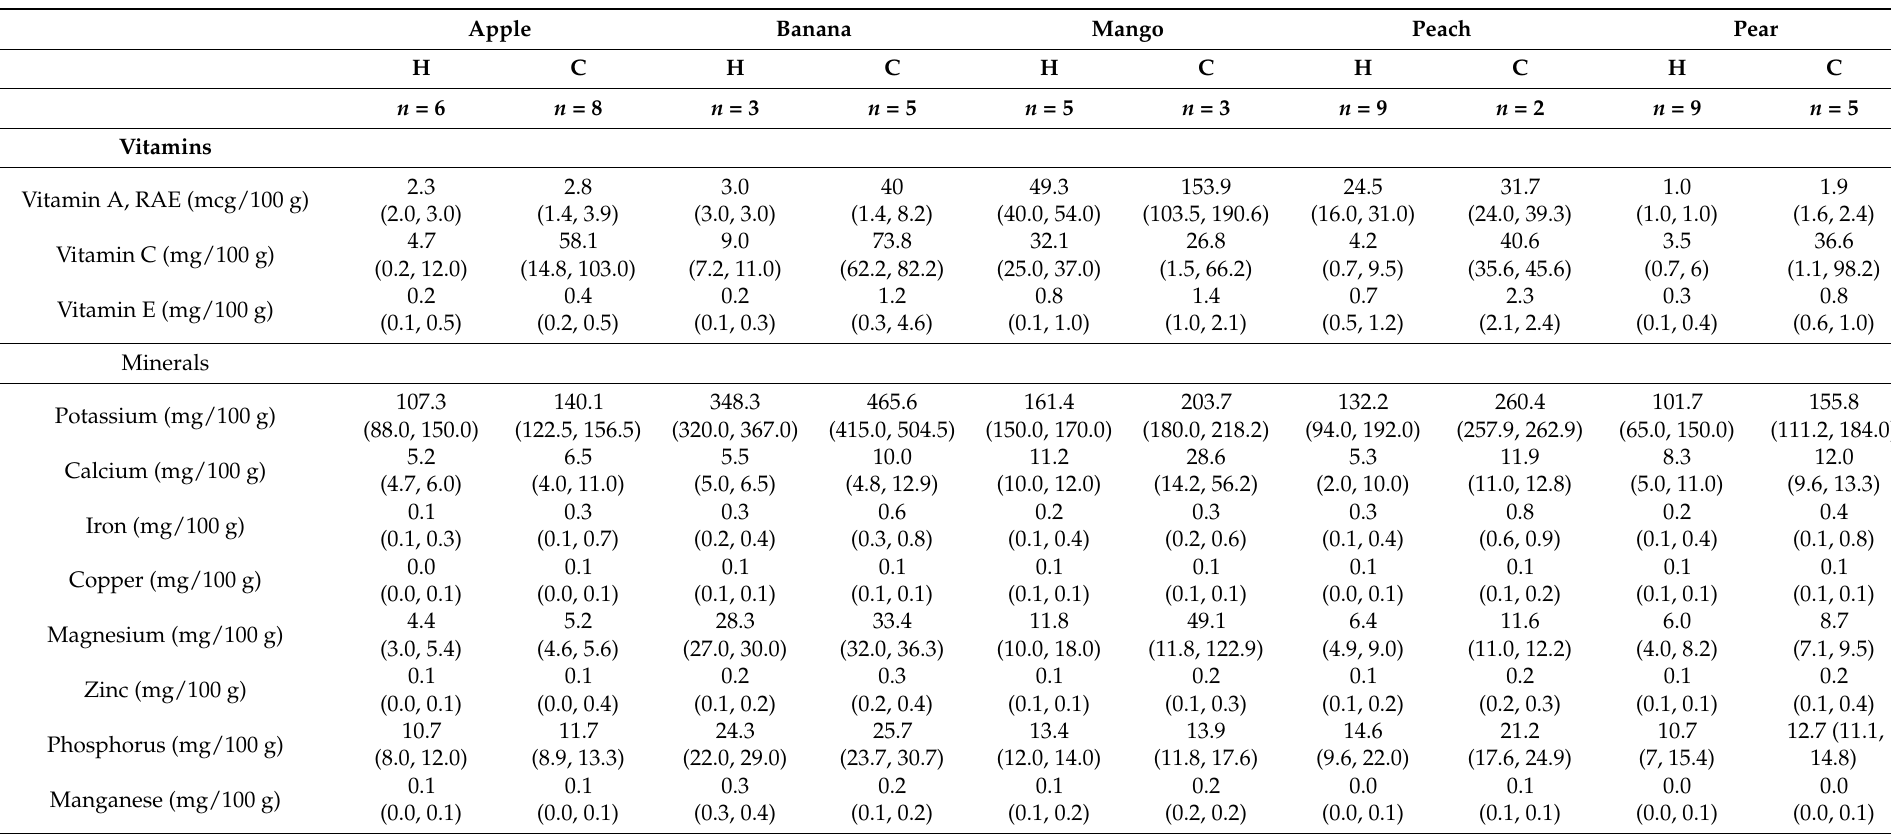
Table 3. Comparison of the food profiles (per 100 g) of external food composition databases and the nutritional profiles of chemically analyzed